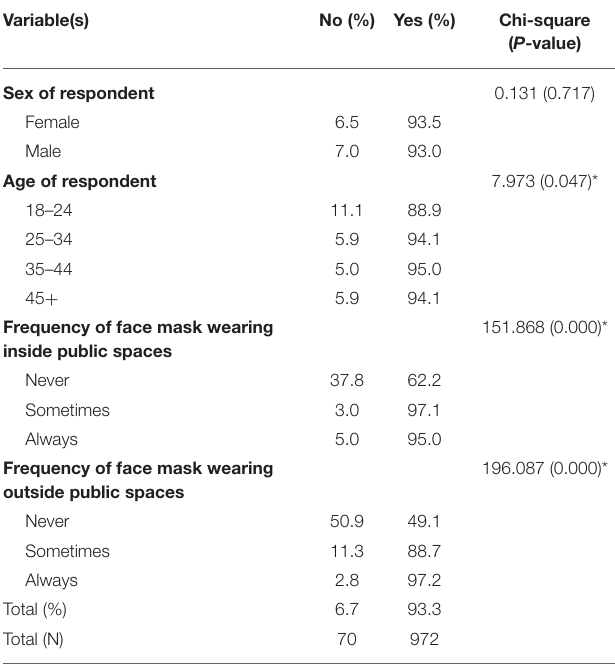
TABLE 3 | Relationship between selected variables and whether wearing a face mask outside public spaces prevents COVID-19 infection.